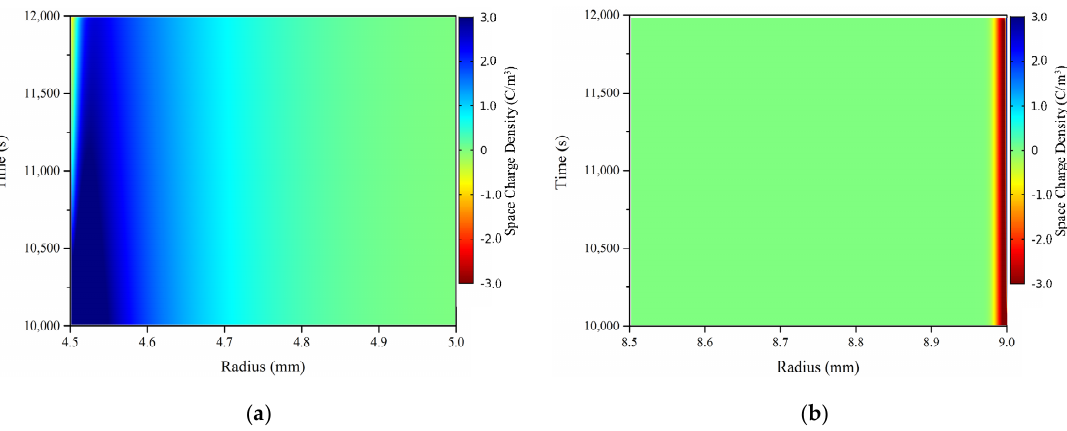
Figure 14. Space charge distribution at 250 A and potential zero duration 1800 s: ( a ) Conductor side density (C/m 3 ); ( b ) sheath side density (C/m 3 ).